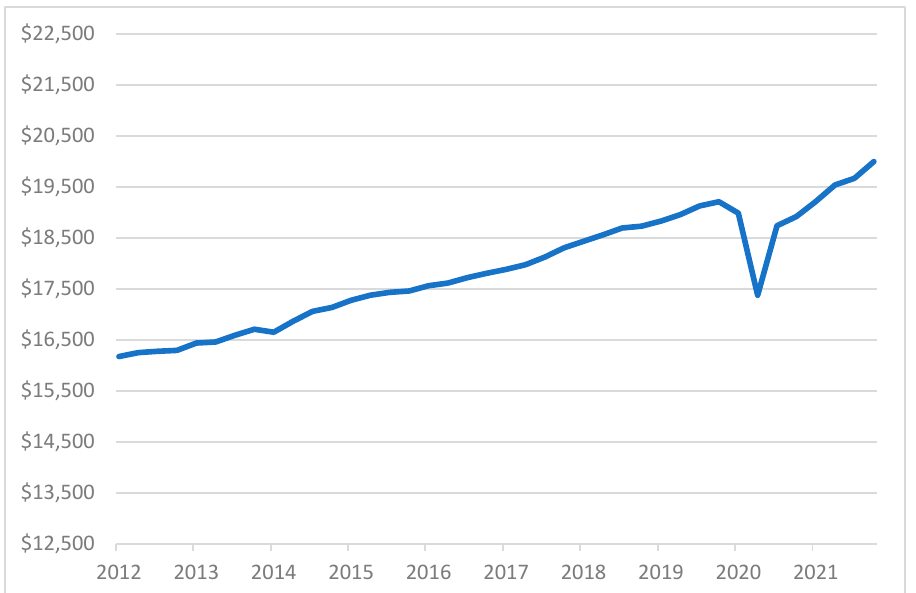
Figure 1. U.S. Real Gross Domestic Product, 2012–2021 (in billions). Source: Created by the Authors. In Figure 2, we provide U.S. inflation rates obtained from the World Bank over the survey period. For the majority of the ten-year time period the U.S. enjoyed low inflation and in the early portion of the survey period many economists were more concerned by deflation than inflation. Only after the economic stimulus provided to the economy due to the COVID-19 pandemic has inflation begun to accelerate. This most recent period of higher inflationary expectations coincides with our final two survey years.